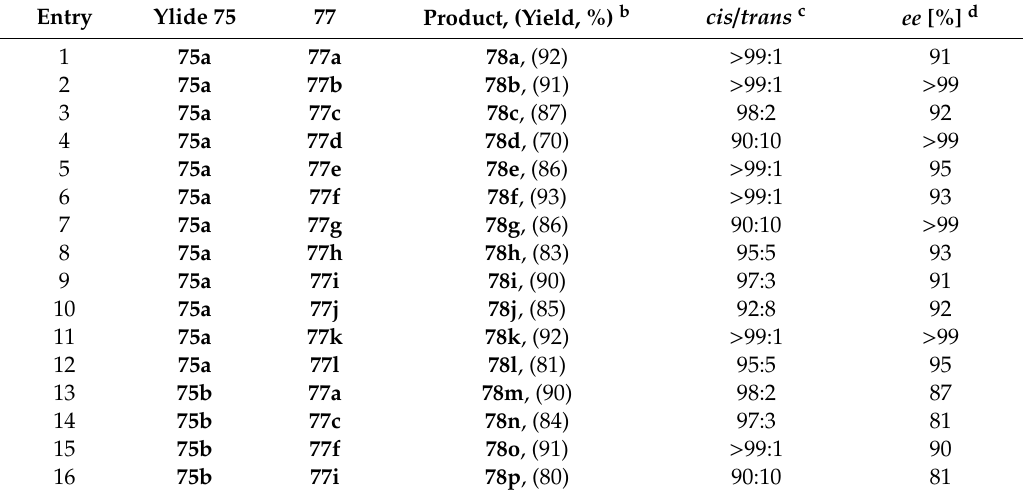
Table 1. Synthesis of cis -(1 R ,2 R ,3 R )-trisubstituted cyclopropanes 78 from exo -camphor-derived selenonium ylides 75a , b . a